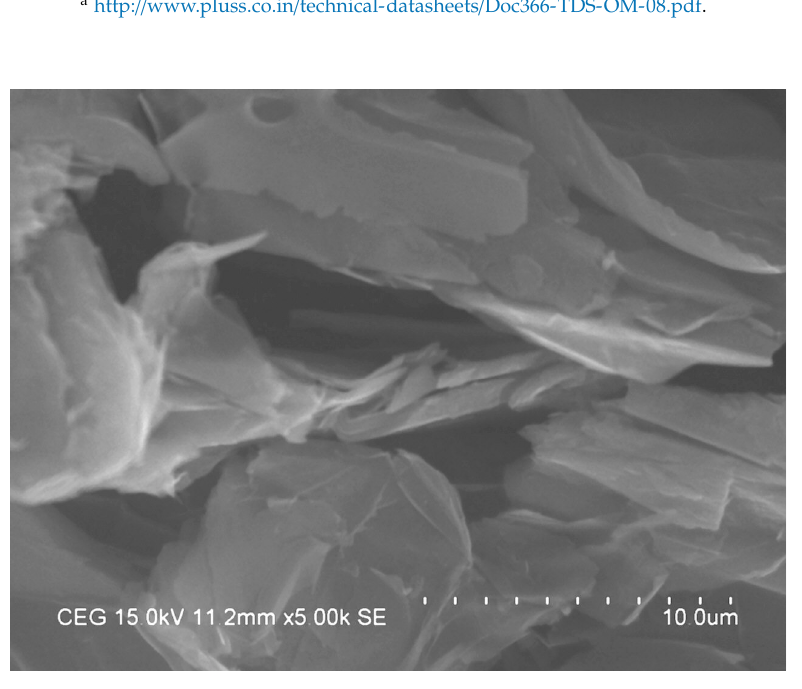
Figure 1. SEM visualization of graphene nanoplatelets (GnPs).